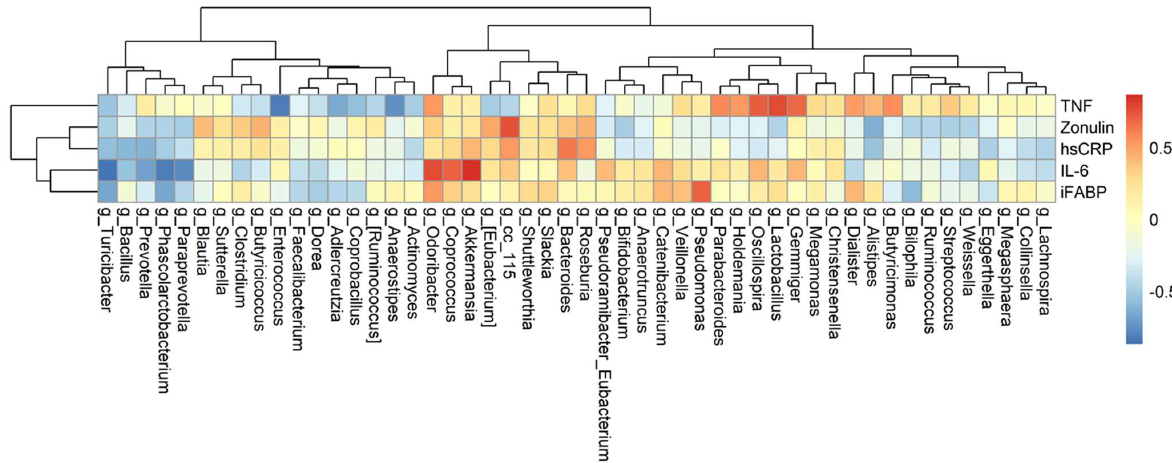
Figure 4. Correlation heatmap between genera and biomarkers. Fifty genera were detected in at least 50% of all 18 fecal samples. The differences in value of 50 genera and that of five biomarkers between two collection times were calculated first and then evaluated for their strength of correlation using Spearman’s correlation. Red denotes positive correlation, and blue denotes negative correlation. Column names of the heatmaps are the genera. The values of five biomarkers (TNF, zonulin, hs-CRP, IL-6, and I-FABP) and the relative abundance of genera were transformed using the logarithm function. Abbreviations: hsCRP, high sensitivity C-reactive protein; iFABP, intestinal fatty acid binding protein; IL-6, interleukin-6; TNF, tumor necrosis factor-α.